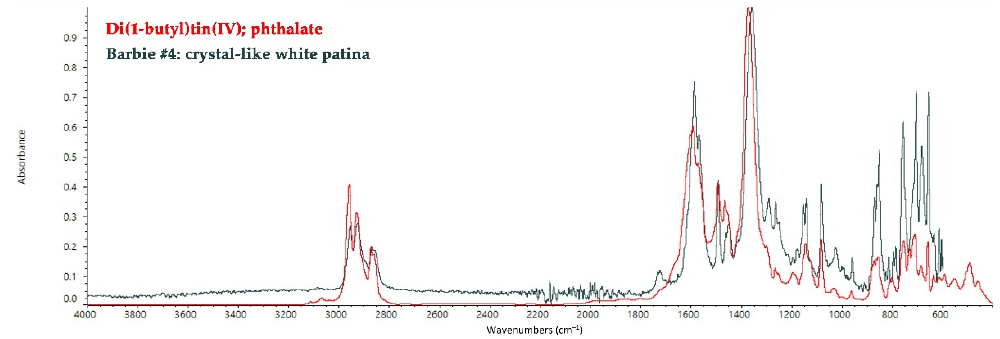
Figure 3. FT-IR ATR spectrum collected on the crystal-like white patina on the torso of Barbie #4, with the reference spectrum of a phthalate-organotin compound.